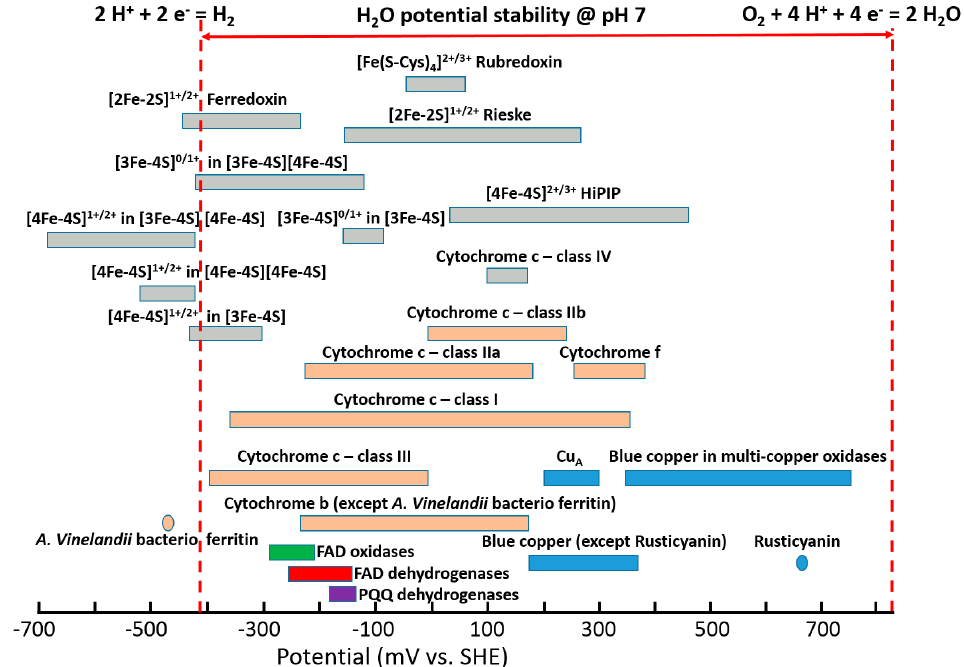
Figure 1. Standard potentials (E°) of various redox proteins and enzymes measured at pH 7.0 and recalculated vs. standard hydrogen electrode (SHE) reference. The potentials spread over range of values for the species originating from different biological sources. The data (except FAD oxidases/dehydrogenases and PQQ dehydrogenases) is adopted from [3] with permission. The potentials of FAD oxidases originate from refs. [7,8]; the potentials of FAD dehydrogenases originate from refs. [9–11]; the potentials of PQQ dehydrogenases originate from [12–15].